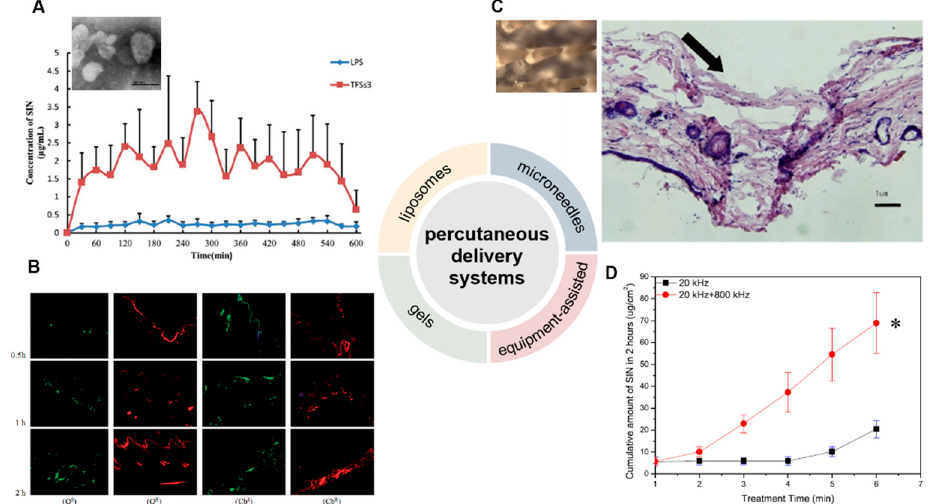
Figure 3. Development of percutaneous delivery systems of SIN. ( A ) The transmission electron microscope of monoterpene edge activated PEGylated transfersomes (×20,000) and the release of SIN after its application to the abdominal skin of rats ( n = 5) [41]. ( B ) laser scanning confocal microscopy images of skin samples for sodium fluorescein-loaded cubic LC gel (Q S ), rhodamine B-loaded cubic LC gel (Q R ), sodium fluorescein-loaded carbomer gel (Cb S ), and rhodamine B-loaded carbomer gel (Cb R ) in Franz cells during different periods (×100) [44]. ( C ) The close-up views of microneedles and the methylene blue-stained frozen section of rat’s abdominal skins treated by microneedles [45]. The arrow means the pierced position. ( D ) Cumulative release of SIN under ultrasound with single- or dual-frequency treatment [48]. (Reprinted with permission from Refs. [41,44,45,48]).